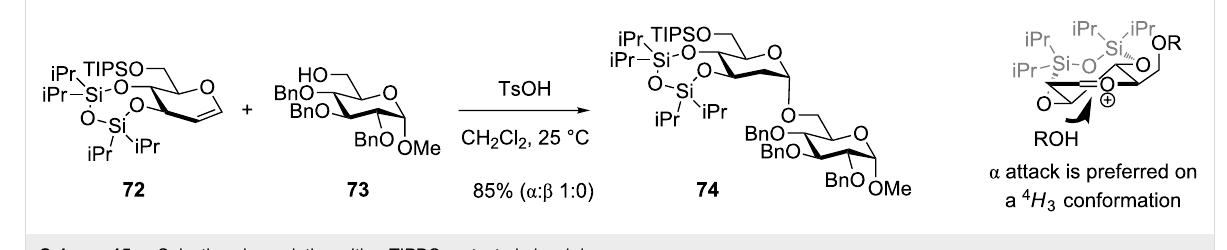
Scheme 15: α -Selective glycosylation with a TIPDS-protected glucal